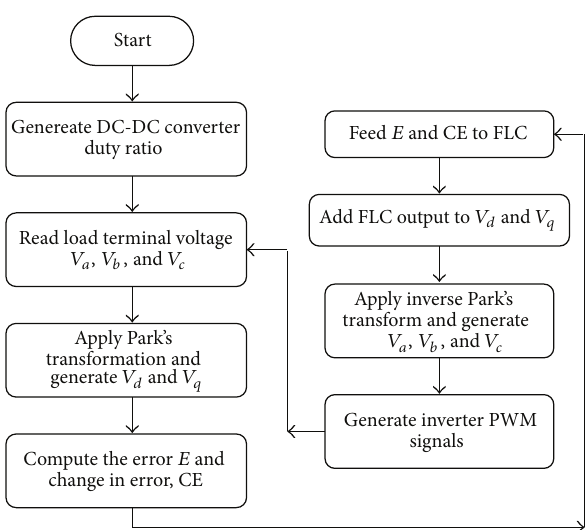
Figure 3: Flowchart of the control